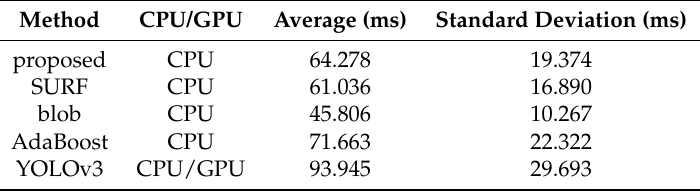
Figure 20. Typical false-negative situations due to low brightness of lamp-type TLs. Table 7. Experimental results: computational